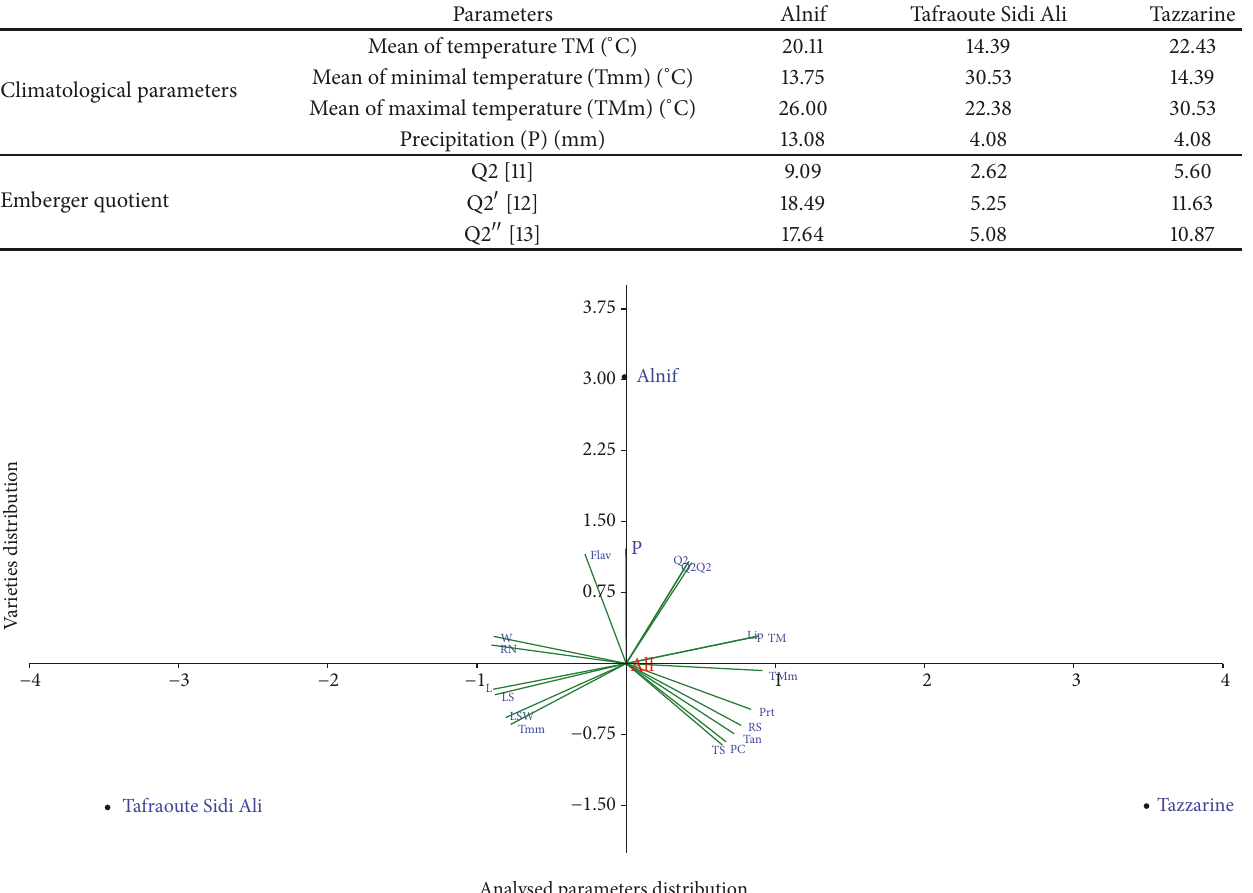
Analysed parameters distribution Figure 4: Dimensional analysis of the morphometric, biochemical, and climatological data of the three varieties of Henna. L: length, W: width, LSW: leaf specific weight, LS: leaf surface, RN: rib’s number, TS: total sugars, RS: reducing sugars, Prt: proteins, Lip: lipids, PC: phenoliccompounds,Flav:flavonoids, Tan: tannins, TM: mean of temperature,Tmm: mean of minimal temperature,TMm: meanof maximal temperature, P: precipitation; Q2: Emberger quotient 1; Q2 󸀠 : Emberger quotient 2, Q2 󸀠󸀠 : Emberger quotient 2 󸀠